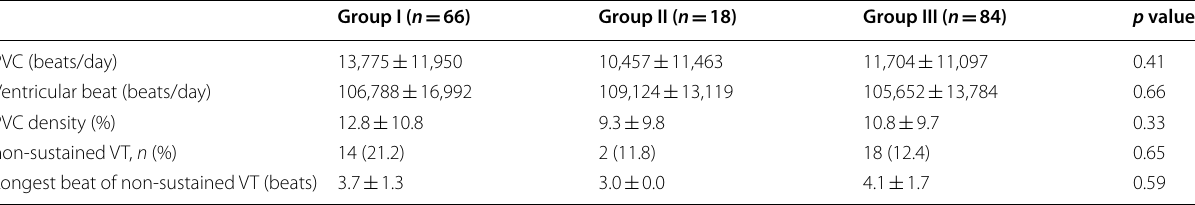
PVC premature ventricular complex, VT ventricular